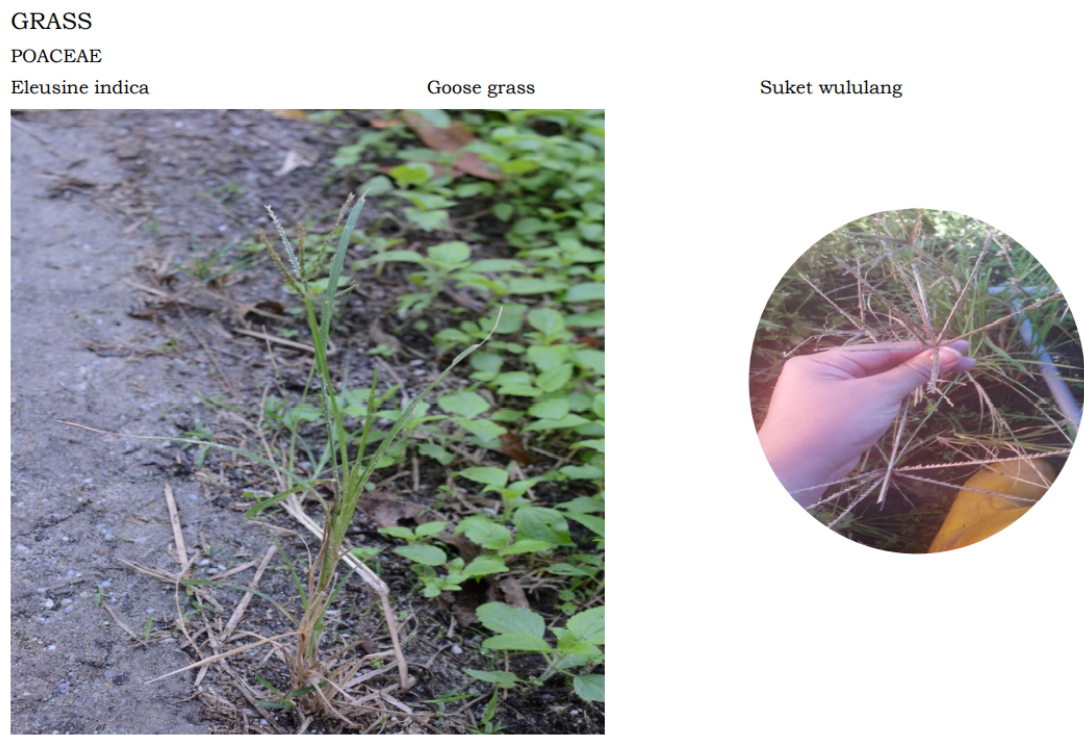
Figure A2. Herb Linderniaceae: Lindernia crustacea .